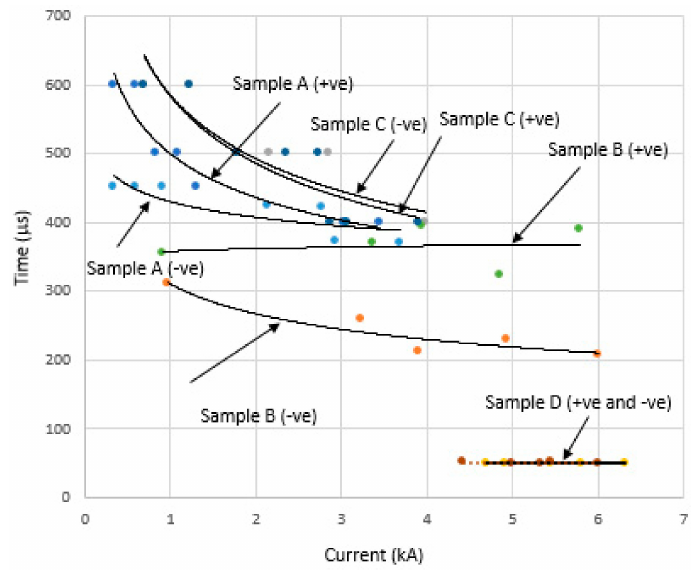
Figure 18. Time to discharge to zero of current trace against peak current for 4-rod electrodes installed at sites 1, 2, 3 and 4, under both impulse polarities.